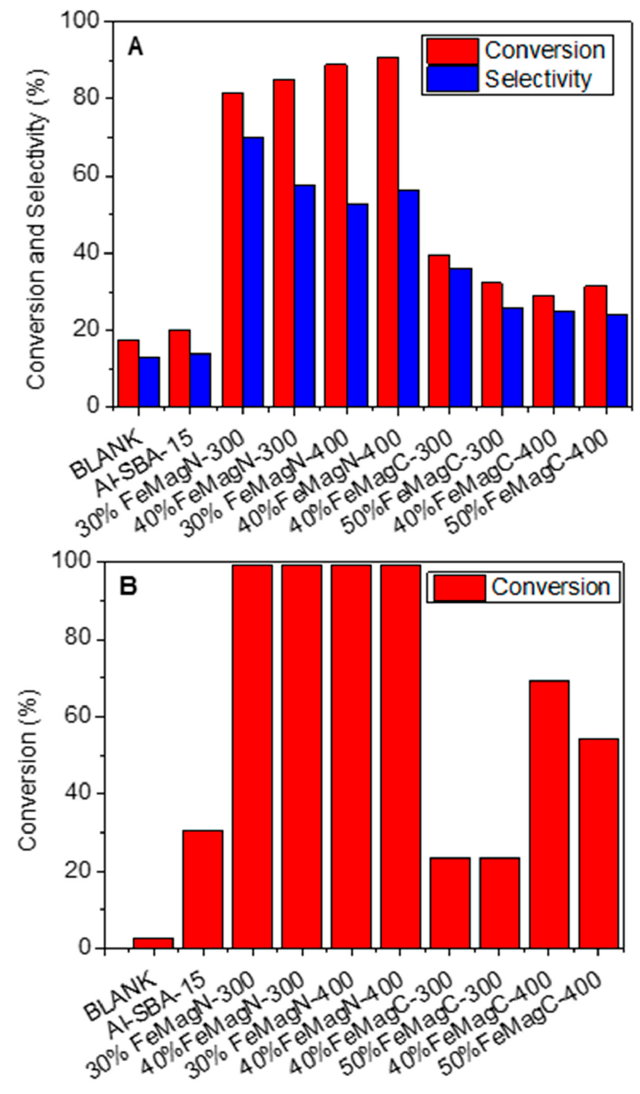
Figure 5. Catalytic conversion and vanillin selectivity (for isoeugenol reaction) for both oxidation reactions at 25 °C, 1 atm. ( A ) Oxidation of isoeugenol at 24 h; ( B ) oxidation of vanillyl alcohol at 20 min. The blank was measured after 2 h of reaction.